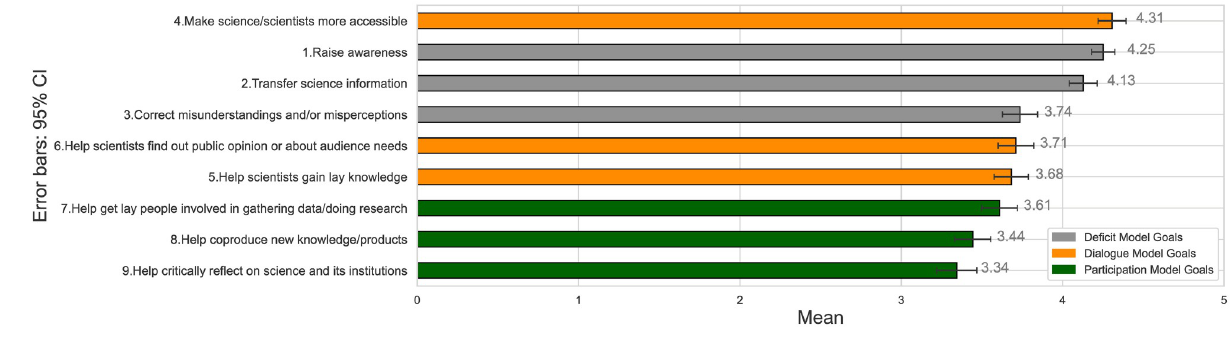
Fig 2. Social media science communication goals ordered by mean ( N =